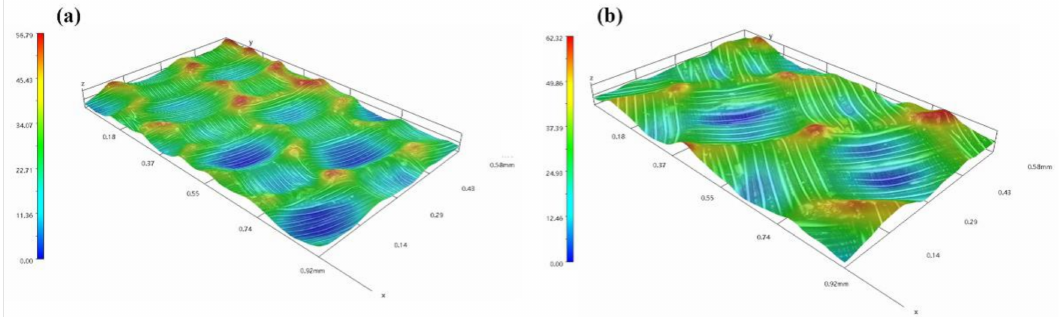
Figure 8. Three-dimensional images of the composite surface ( a ) after removing of the wet peel ply ( b ).